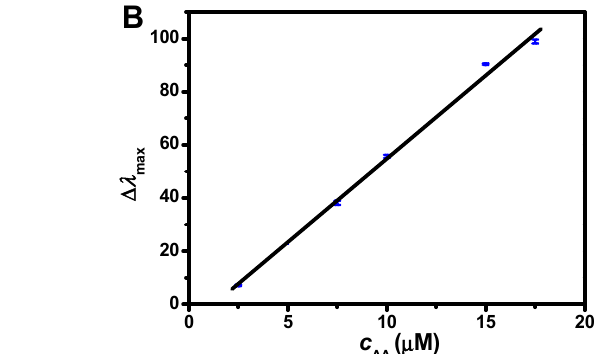
Figure 6 . AA detection based on the red shift of λ max . ( A ) Spectral variations of silver-coated gold nanorods in the presence of different concentrations of AA (from bottom to top: 0 μ M, 2.50 μ M, 5.00 μ M, 7.50 μ M, 10.00 μ M, 15.00 μ M, 17.5 μ M). ( B ) The standard curve for AA detection. Conditions: Au@Ag NRs, 50 μ L; H 2 O 2 , 450 μ M; Fe 2+ ; 0.25 mM; HCl, 0.10 M; t, 25 min; and T, 45 °C.